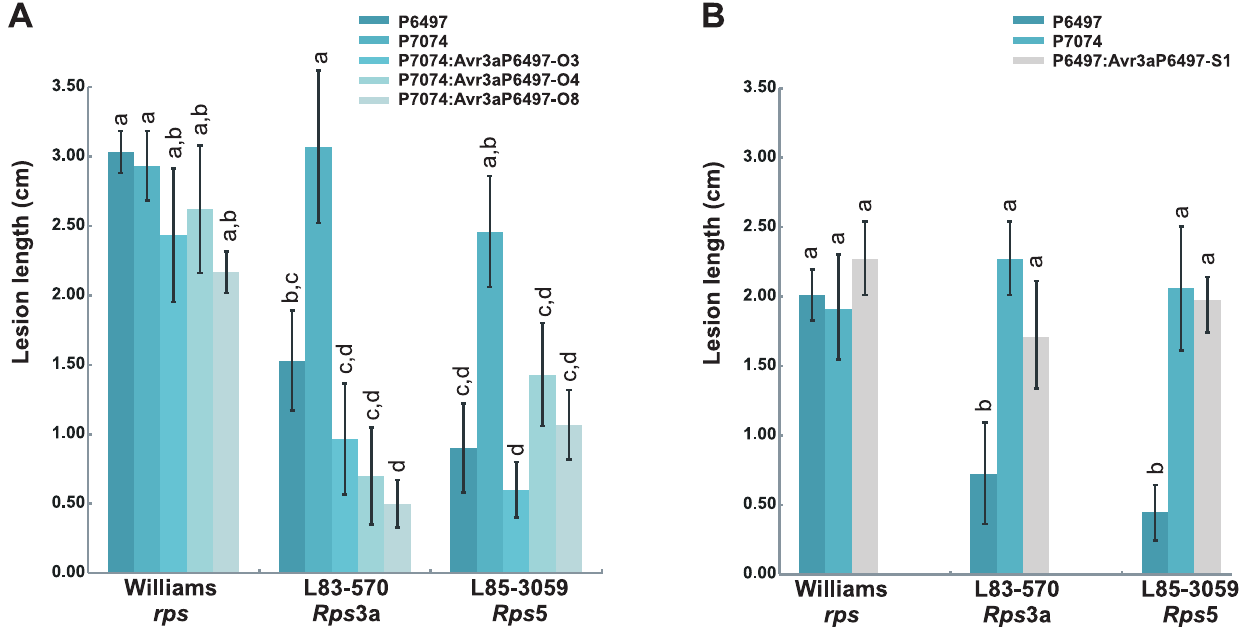
Figure 5. Disease lesion lengths in etiolated soybean hypocotyls infected with zoospores of wild-type and Avr3a transformed strains of P.sojae , 36 h after inoculation. Mean and standard error from at least 20 measurements are shown in each case, with results from Duncan’s multiple range test (1% significance) indicated above each column. (A) Ectopic over-expression of Avr3a P6497 causes loss of virulence to Rps 3a and Rps 5 in strain P7074. Shown are results from wild-type strains P6497 and P7074, and transgenic over-expressing strains P7074:Avr3a P6497 - O3, P7074:Avr3a P6497 -O4, and P7074:Avr3a P6497 -O8. (B) Silencing of Avr3a P6497 causes gain of specific virulence in the presence of Rps 3a and Rps 5 in strain P6497. Shown are results from wild-type strains P6497 and P7074, and transgenic silenced strain P6497:Avr3a P6497 -S1.